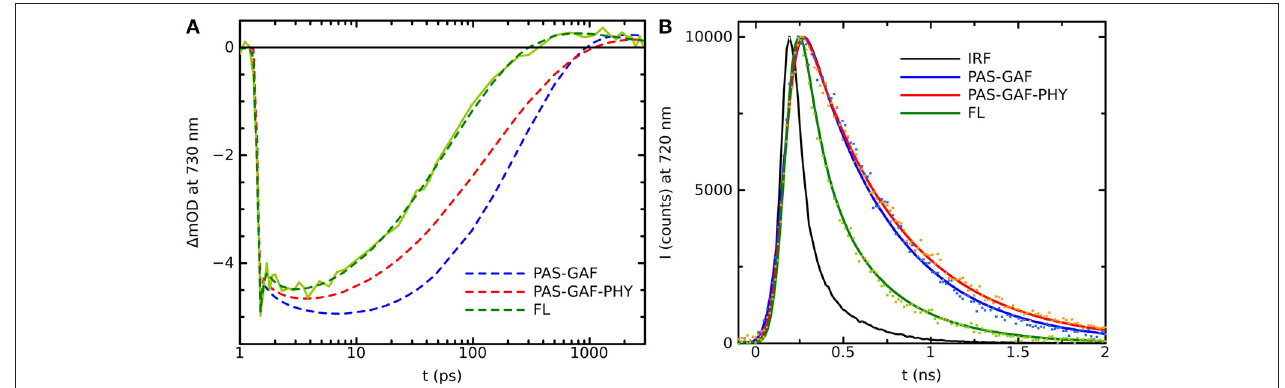
FIGURE 2 | (A) Transition absorption decay traces of PAS-GAF (blue), PAS-GAF-PHY (red), and FL (green) from Deinococcus radiodurans excited at 656nm and monitored at 730nm. Solid lines show the multiexponential fit of the data, which result in following characteristic lifetimes of each complexes are: 1.5, ps and 320 ps for CBD; 1.2 ps and 170 ps for CBD-PHY; 0.5 ps and 70 ps for FL. (B) Emission decays of PAS-GAF, PAS-GAF-PHY, and FL from Deinococcus radiodurans excited at 660nm and monitored at 720nm. IRF is the instrument response function. The corresponding average lifetimes are: 410 ps for CBD; 550 ps for CBD-PHY; 340 ps for FL. The fluorescence quantum yields are 0.034, 0.017, and 0.008 for CBD, CBD-PHY, and FL, respectively. The samples were prepared as described in Takala et al. (2014b). The pump–probe technique for time-resolved absorption was used to detect fast processes with a time resolution shorter than 0.2 ps. A laser setup with an integrated one-box femtosecond Ti:sapphire laser (Quantronix Integra C) was used to pump two home-built non-collinear optical parametric amplifiers (NOPAs) to produce the (656 ± 14) nm pump pulses. A white light continuum generated in a sapphire crystal was used for probing. After the sample, the probe and reference beams entered a monochromator (Acton), and the detection was set to (730 ± 8) nm. Fluorescence decays of the samples in the nanosecond time scales were measured using a time-correlated single photon counting (TCSPC) system (PicoQuant GmBH). The excitation wavelengths were 660nm. The